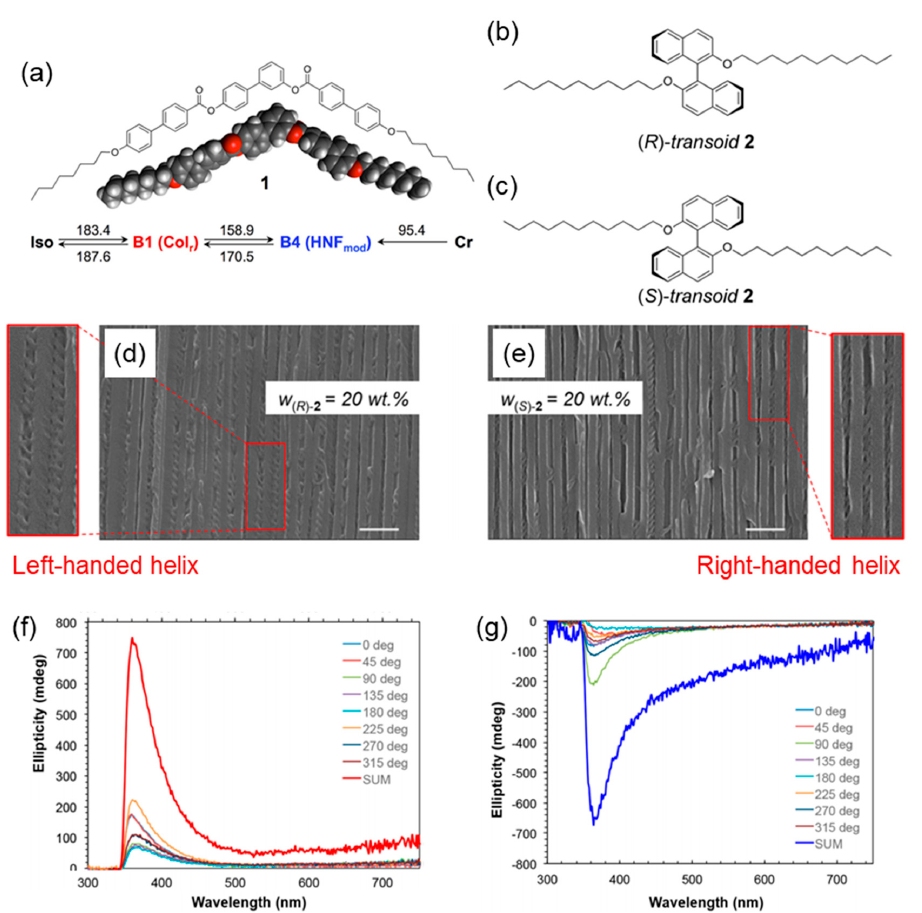
Figure 7. ( a ‒ c ) Chemical structure of bent-core LC molecule and chiral dopants with opposite handedness. ( d , e ) Cross-sectional SEM images of HNFs in each AAO pore with different chiral dopants. Under different chiral dopant conditions, the handedness of HNFs is controlled following the chirality of the mixed dopant. CD spectra of ( f ) left-handed and ( g ) right-handed helix. To eliminate the effect of dichroism and birefringence, the sample stage was rotated during the measurement. The rotated degree and its CD results are expressed together. Reprinted with permission from [70], Copyright 2020, American Chemical Society.